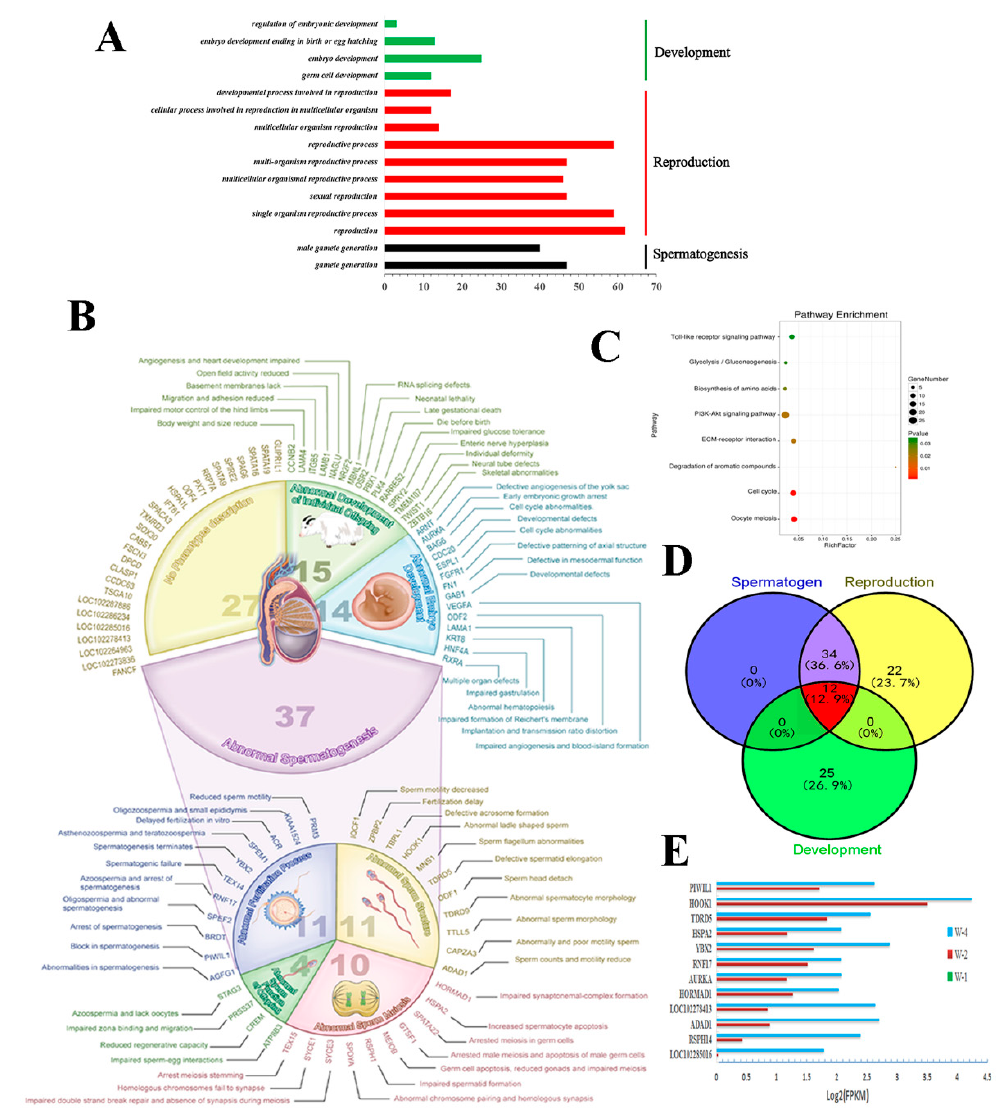
Figure 3. Gene ontology (GO) analysis of different expressed genes in transcriptome and small RNA sequencing. ( A ) The GO terms were clustered into three biological processes (development, reproduction, and spermatogenesis). ( B ) The potential function prediction and annotation of 93 unique DE genes from the MGI database based on homology. ( C ) Pathway enrichment of three significantly different profiles. ( D ) The Venn diagram was constructed based on 93 DEGs. ( E ) The relative expression levels of identified DEGs were calculated by the FPKM value.